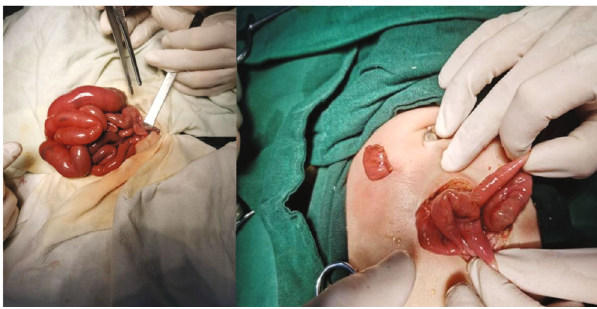
Figure 1: Diagram of fi stula surgery. Table 1: General baseline information and fi stula location of the children.